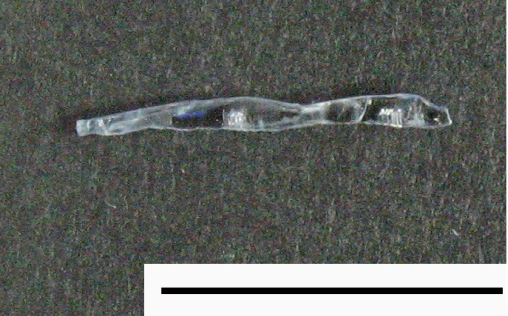
Figure 4. Grown crystal from the K:Nb = 54:46 melt, reprinted with permission from [24]. Copyright 2006 Elsevier. Scale bar: 10